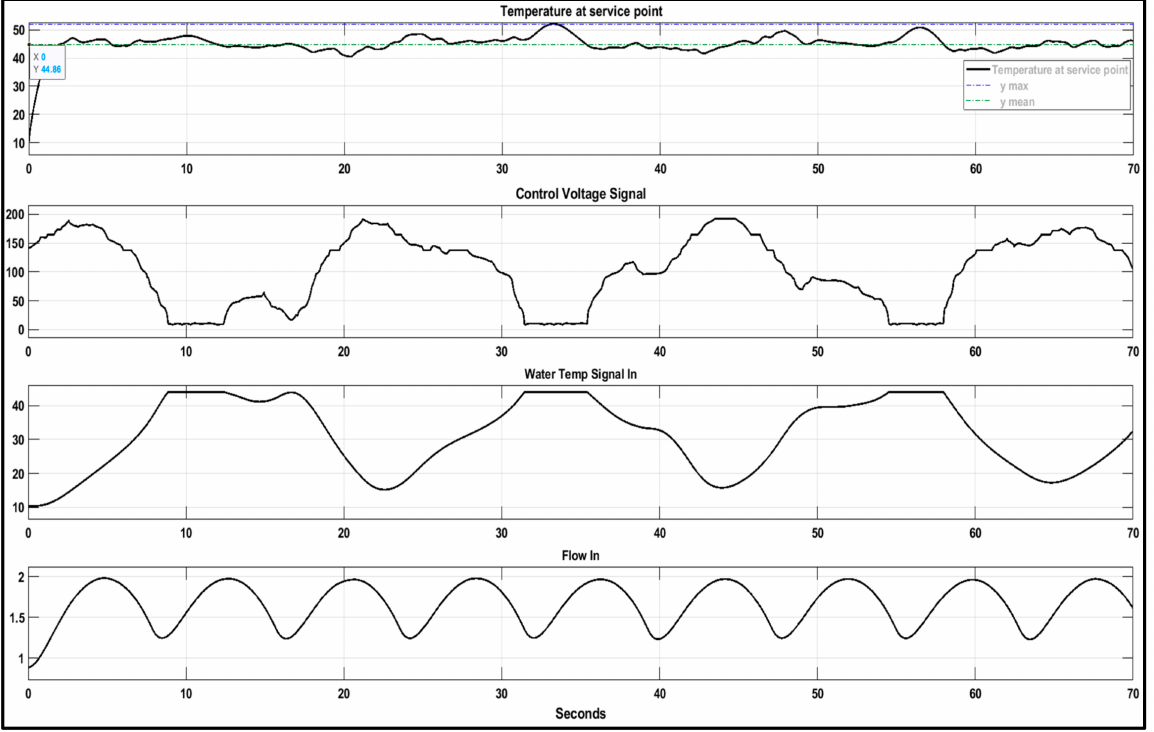
Figure 8. Nonlinear “Fast” flow fluctuation performance of the fuzzy